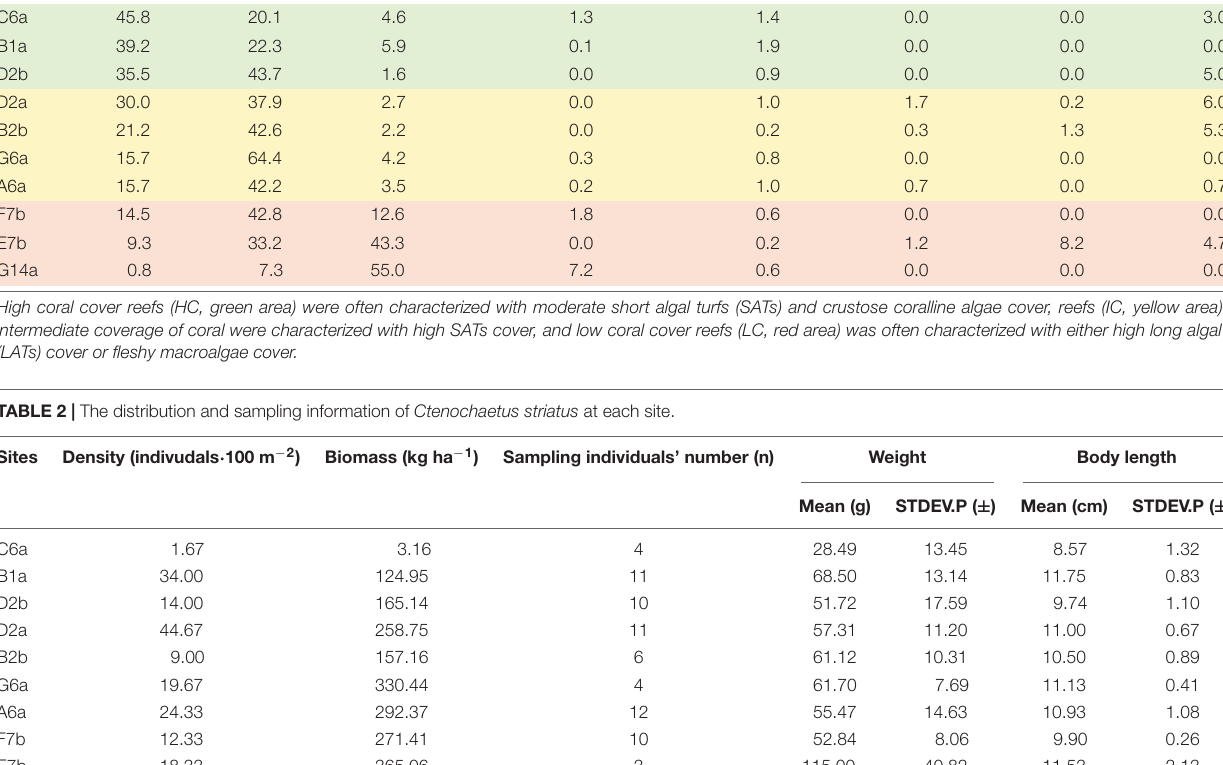
TABLE 1 | Benthic community composition of the study sites revealed different habitat characteristics among the reefs. Sites Coral (%) SATs (%) LATs (%) Fleshy macroalgae (%) CCA (%) Soft coral (%) Sands (%) Others (%)